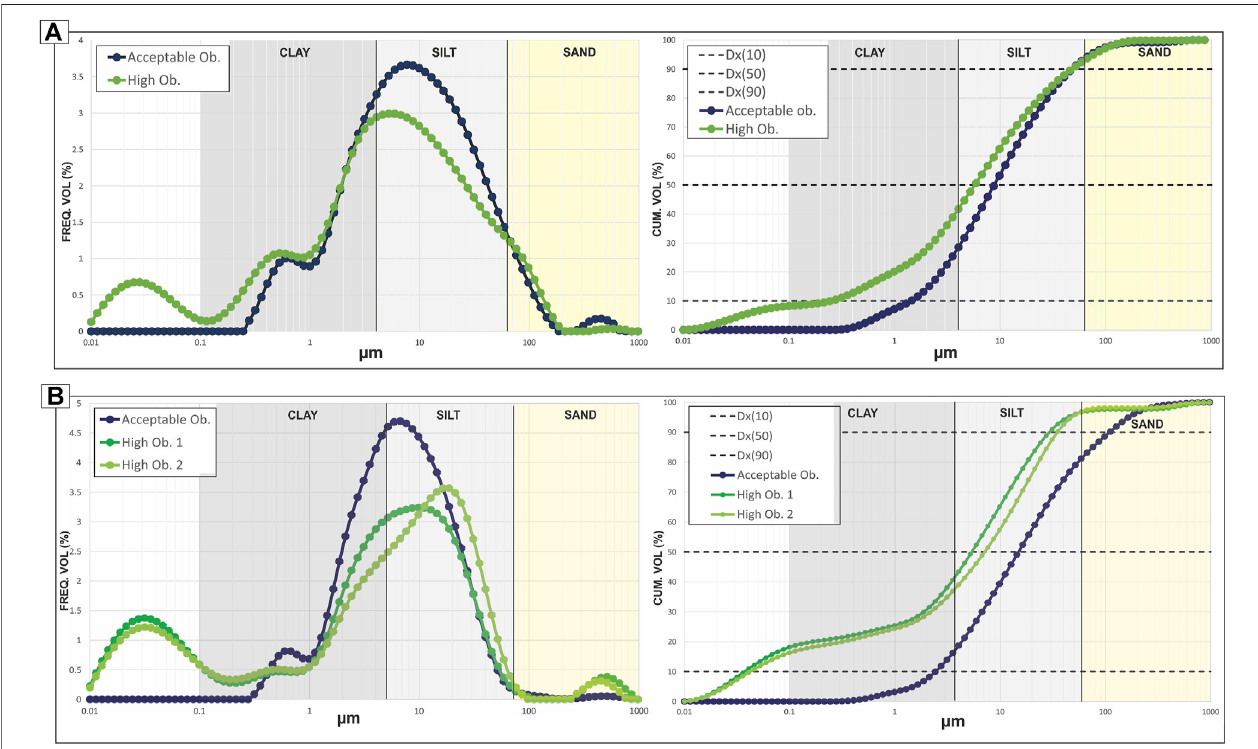
FIGURE 4 | Volume frequency and cumulative frequency graphs showing two versions of the same subsample: the green with too much material added to the Mastersizer, resulting in obscuration that is above reliable measurement, and the blue showing a sample that is within obscuration limits. Data are from the Marnoso- ArenaceaFormation. (A) Location Coniale 1,Bed2(Amy andTalling, 2006),Sample4,interpretedasaturbidite.Theacceptable obscuration inblueis20.61%,thehigh obscuration ingreenis26.46%. (B) LocationConiale2,Bed0.4(Amyand Talling, 2006),Sample7,interpretedasahybrideventbed.Theacceptableobscuration in blue is 19.74%, the high obscuration examples are 44.21 and 44.66%. For details Supplementary Table S1